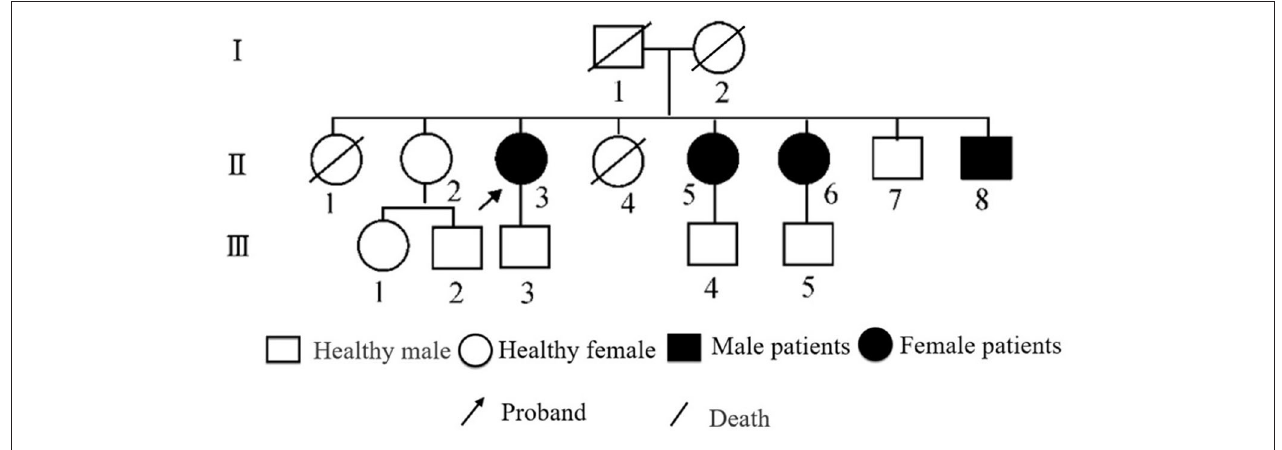
FIGURE 1 | Genetic family diagram of the